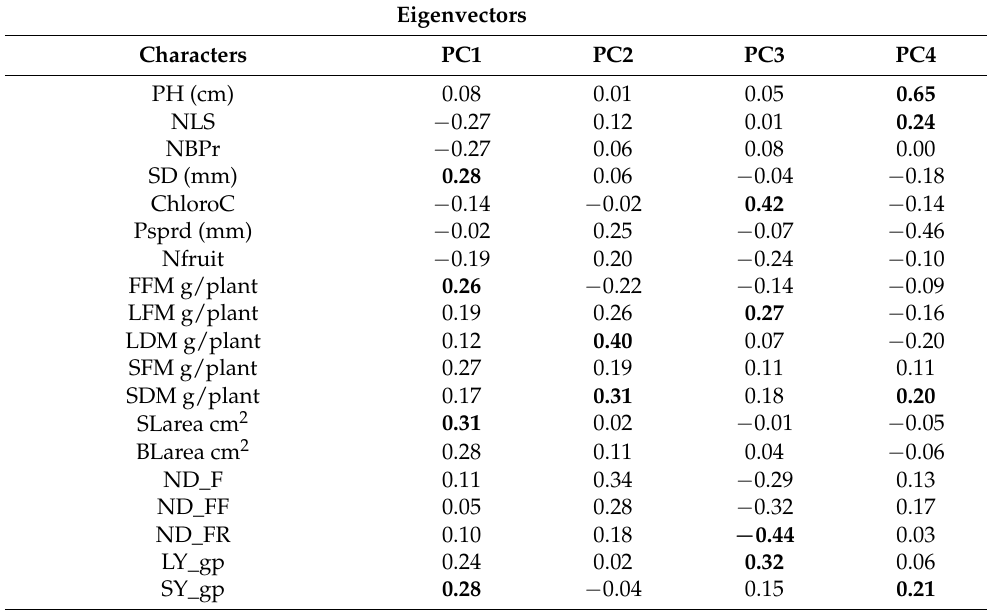
Table 3. Principal component analysis for 22 quantitative traits indicating eigenvectors, eigenvalues and proportion of variation explained with the four PCs